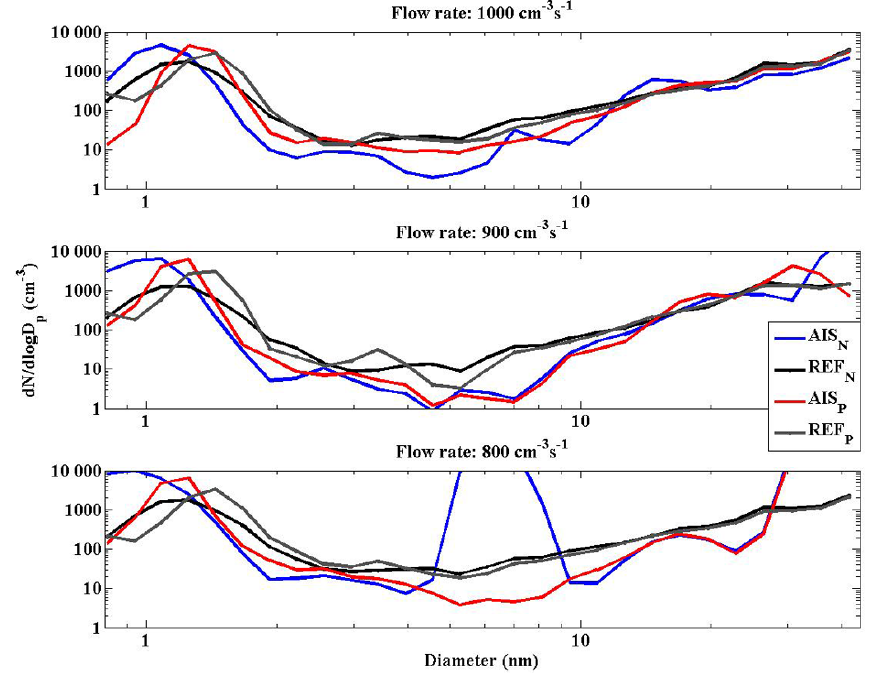
Fig. 3. Average size distributions measured with the AIS and a reference ion spectrometer at different flow rates during flow rate experiments. The negative polarity is symbolised with the letter N and the positive polarity with